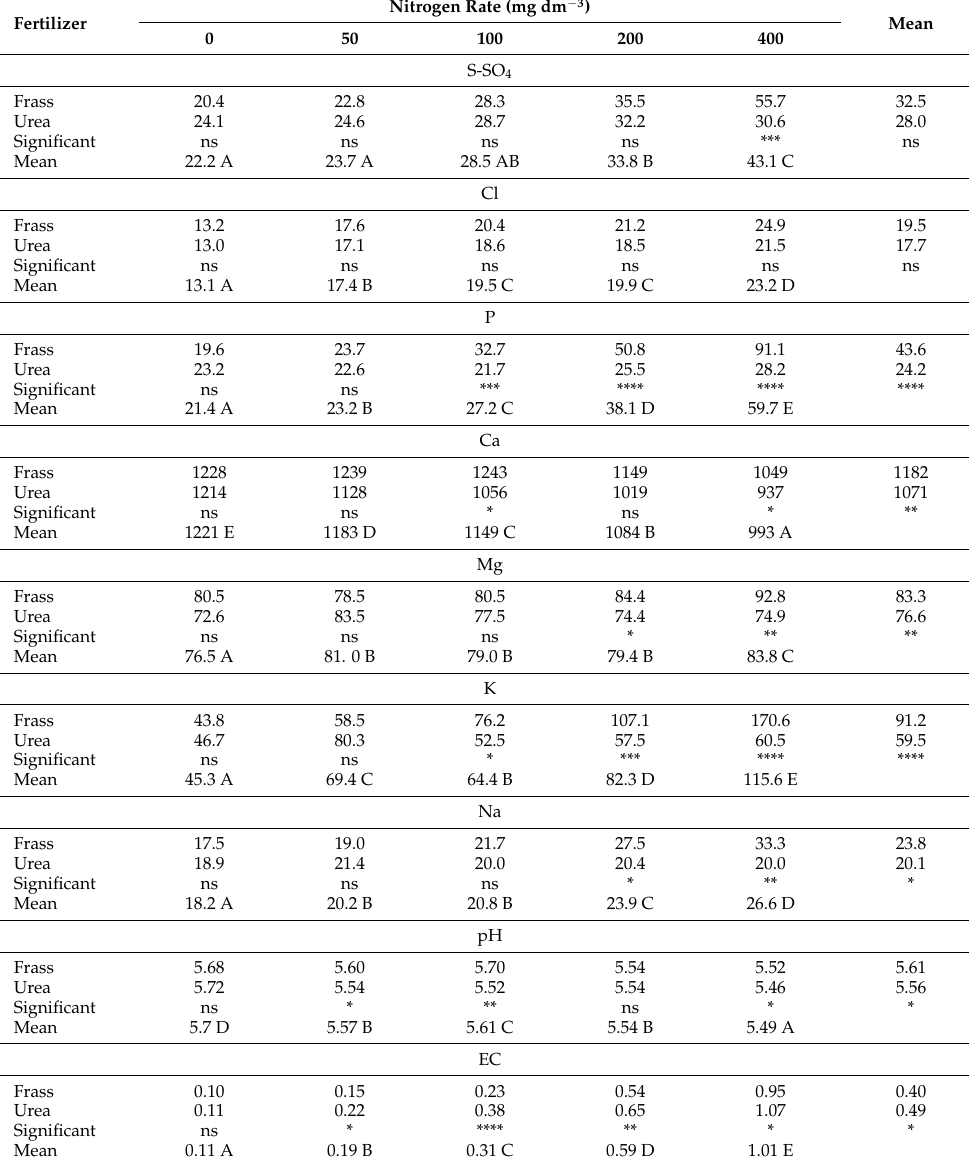
Table 2. Average content of nutrients and the pH and electrical conductivity (EC) of deacidified peat supplied with different fertilizers and nitrogen rates.